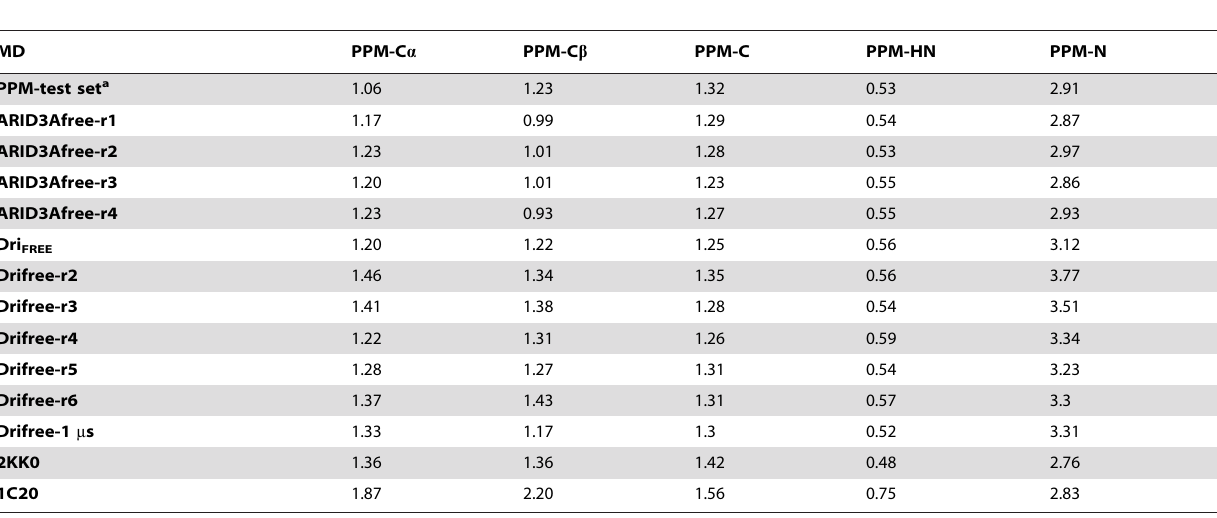
Rmsd between calculated and experimental backbone chemical shifts are reported. In particular, chemical shifts were calculated for C, N, HN, C b , and C a atoms on structures from the equilibrium trajectories collected every 100 ps. a For comparison, the deviations between experimental and PPM-predicted chemical shifts for protein test sets are provided as reported in ref. [12].